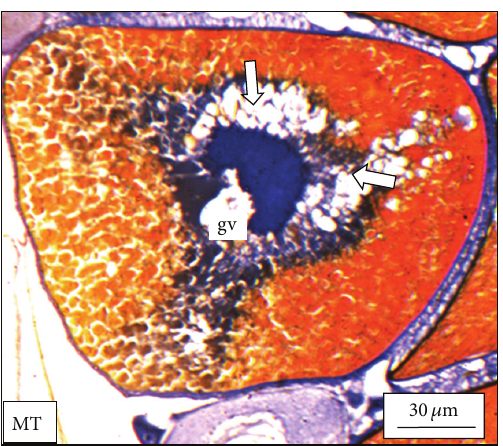
Figure 4: The histological section of a mature ovary of M. tengara during the spawning phase (June) showing the presence of mature ovum (mo), atretic follicle (af), and discharged follicle (df) under controlled condition [Mallory’s triple stain].